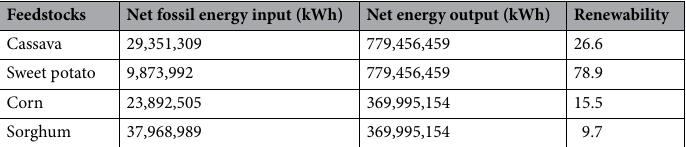
Table 9. Energy renewability.